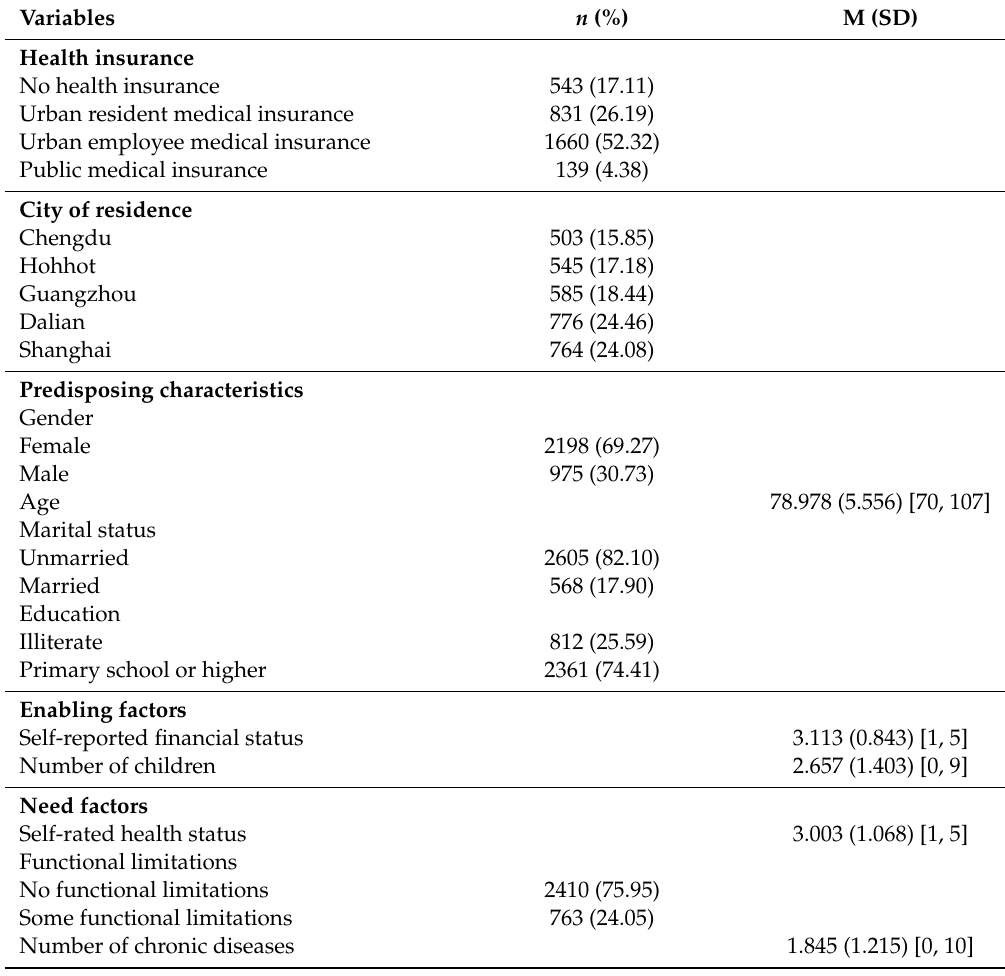
Table 1. Sample characteristics ( n = 3173).